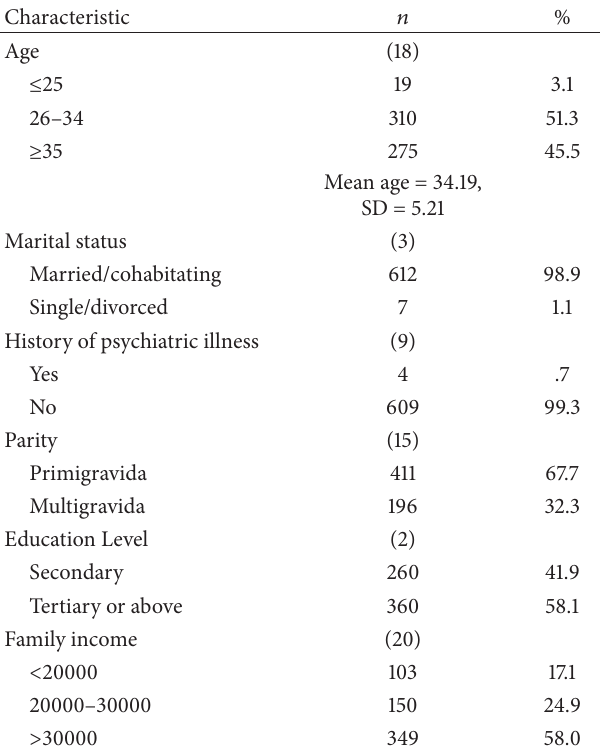
Table 3: Sample characteristics of expectant fathers in the present study.